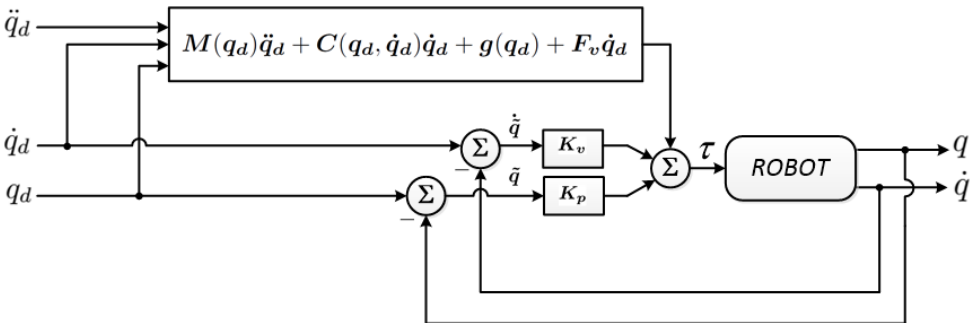
Figure 2. PD Control plus Feedforward diagram simplified to better show the feedforward block that formed by the dynamics of the robot evaluated at the desired